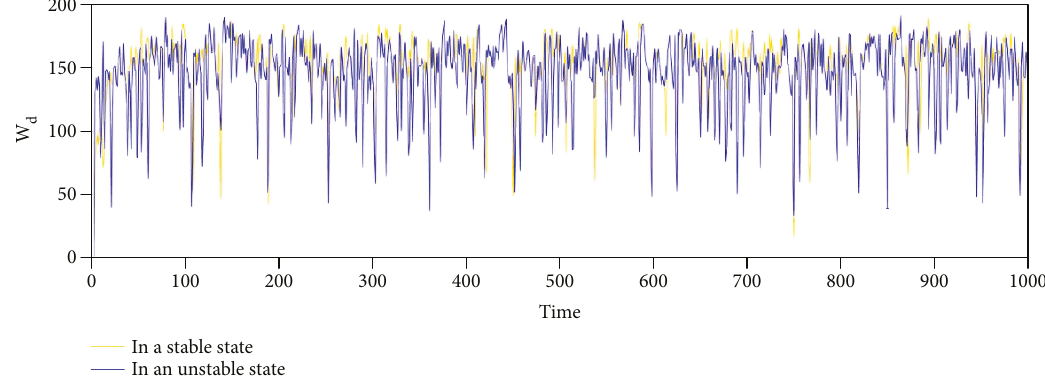
Figure 16: Comparison of retailers ’ initial stock changes in a stable state and unstable state under the scenario of random demand obeying uniform